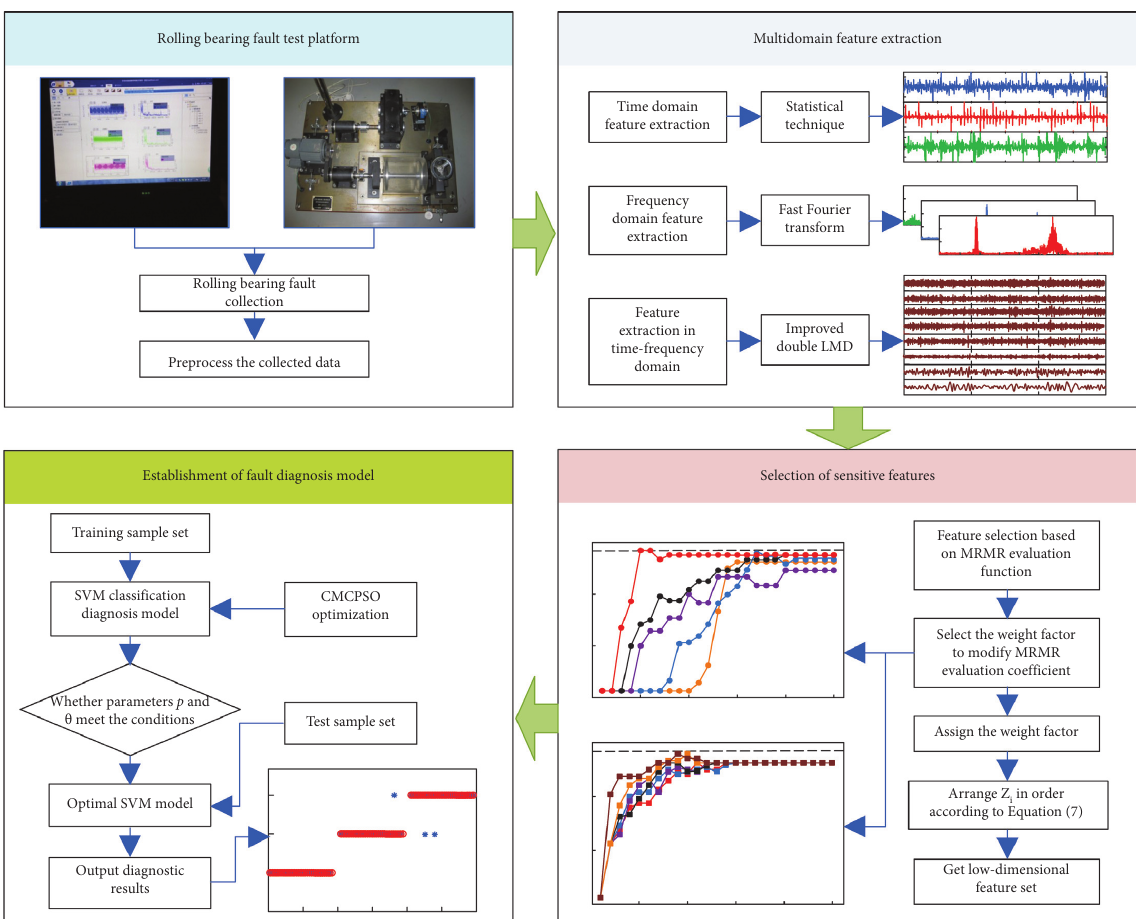
Figure 2: The flow chart of rolling bearing fault diagnosis in the mixed domain.